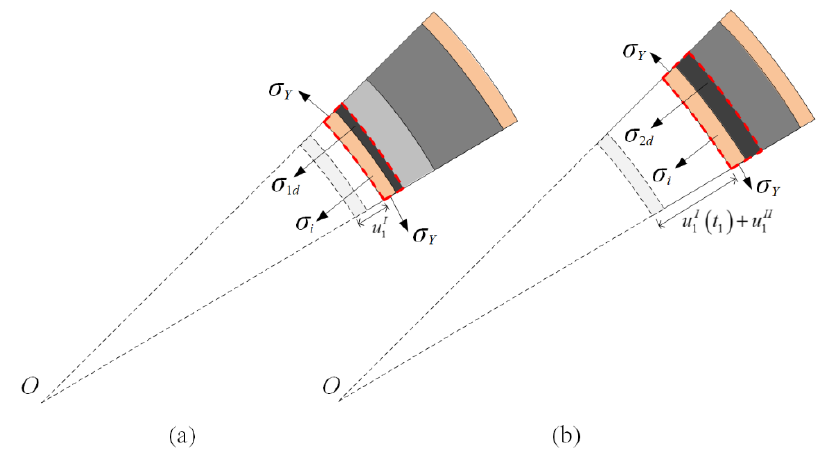
Figure 4. Stress analysis for a cylinder with a positive-gradient core. ( a ) Stage I, and ( b ) stage II.